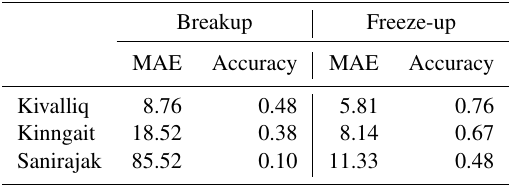
Table 3. Discrepancy between breakup and freeze-up dates derived from ERA5 and CIS regional ice charts. MAE refers to the mean ab- solute error (days). Accuracy is the fraction of freeze-up or breakup events for which the baseline dates are within 7d of each